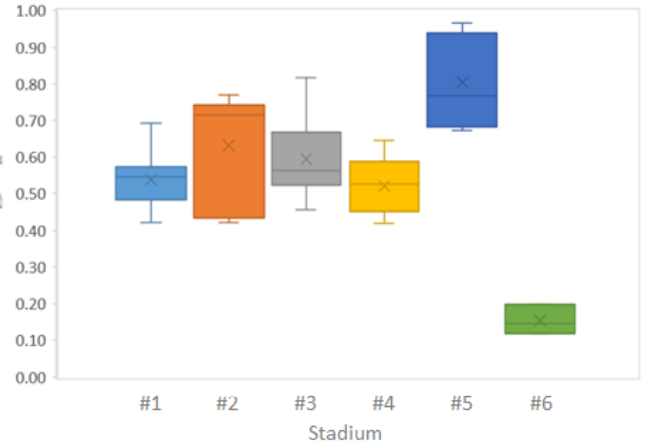
Figure 4. Mean PM 2.5 /PM 10 ratios for the full monitoring period in each location.